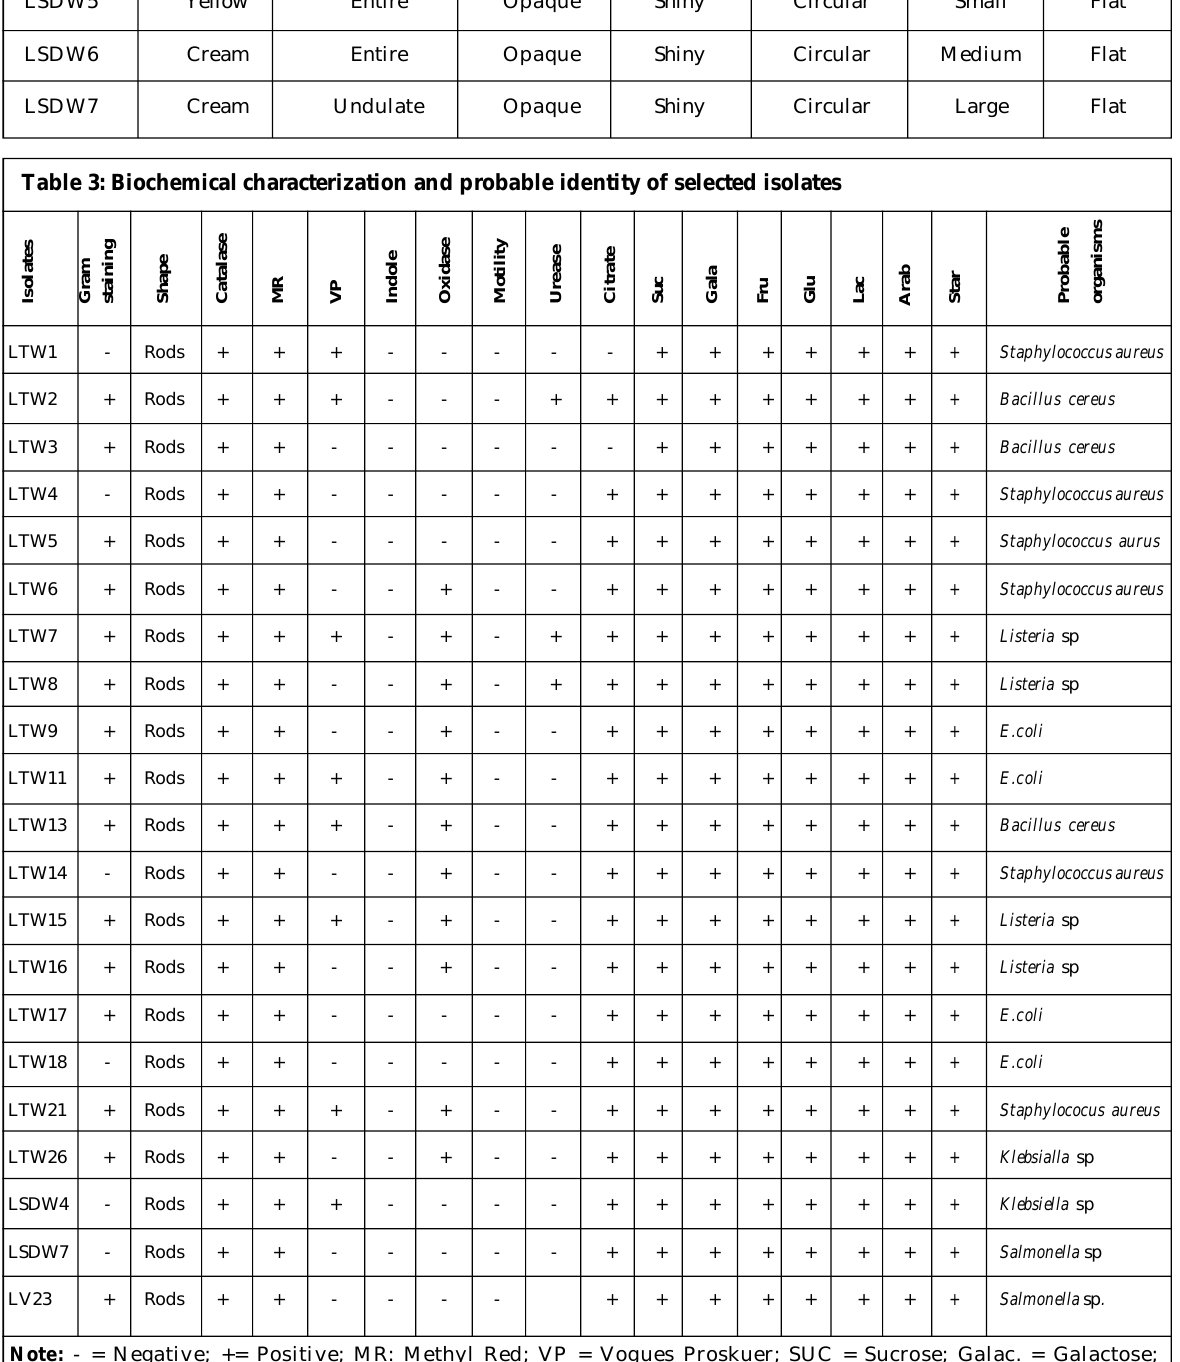
Table 3: Biochemical characterization and probable identity of selected isolates